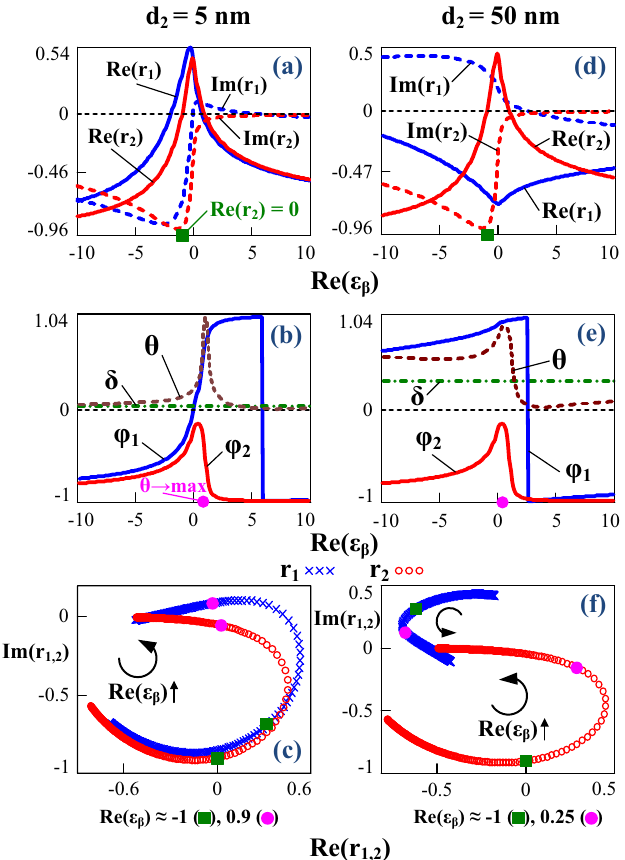
Fig. 3. The effect of parameter e 0 b on the real and imaginary parts of amplitude re fl ection coef fi cients of waves 1 and 2 (a, d), phase differences ’ 1,2 , d , angle u (b, e) and trajectories of the tips of vectors r 1,2 on the complex plane (c, f). The main layer thickness is: d 2 =5 nm (a, b, c), 50 nm (d, e, f). The values of parameters for all the graphs are: c =0, d 1,3,4 =0, l =650 nm, e 00 b ¼ 0 : 2 , m b = 1, the main layer material is vanadium dioxide. The black horizontal dashed line in a, b, d, e characterizes equality to zero of the corresponding quantities. The explanations of characteristic points in all the graphs (the points are denoted by small squares and circles) are given in a, b. The arrows in fi gs. c, f point to the direction of motion on the trajectories (c, f) for increasing e 0 b values. Parameters e 0 b and r 0 1 ; 2 are used as the abscissa axis for graphs (a, b, d, e) and (c, f),